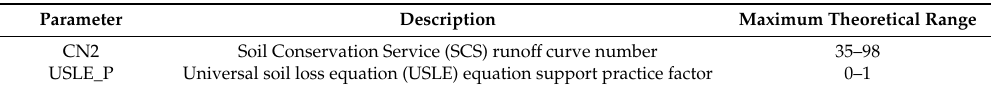
Table 1. The parameters for model calibration and validation and their maximum theoretical